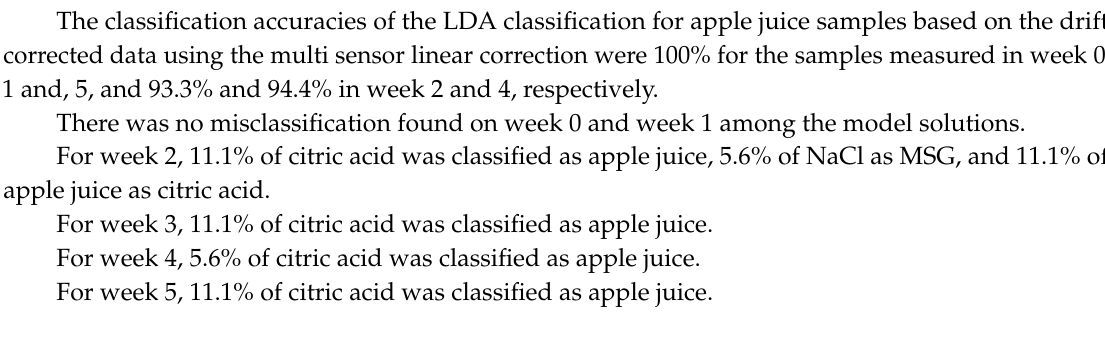
Figure 8. Linear discriminant analysis plots for the drift corrected dataset using the multi sensor linear correction method of the e-tongue measurements of apple juice samples (red symbols) and model solutions: citric acid (green symbols), NaCl (gold symbols), and MSG (gray symbols). The solid circles indicate the measurements on week 0 which was used to build the linear discriminant analysis model, and the di ff erent symbols (diamond, triangle, plus, asterisk, and circle) stand for the di ff erent weeks 1–5,